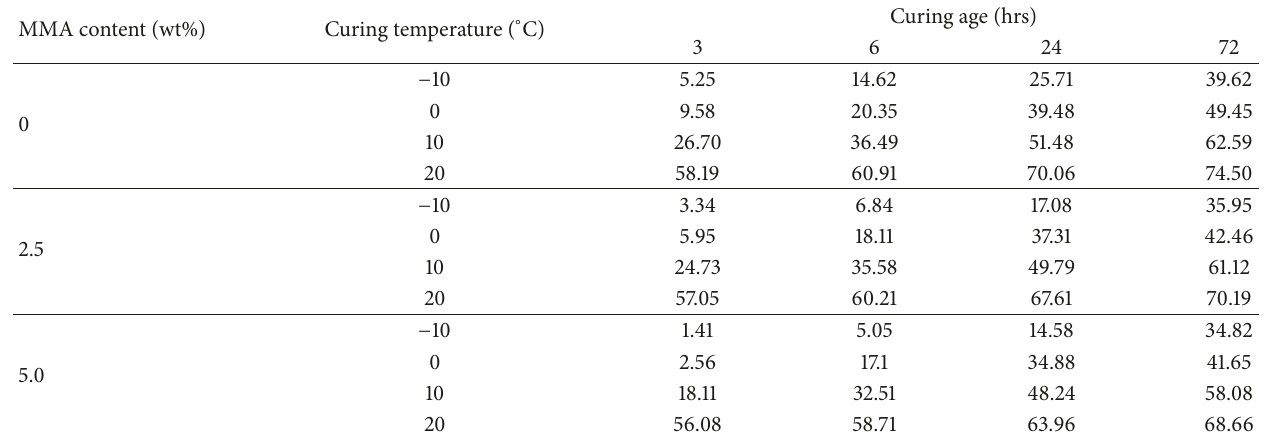
Table 9: Test results of compressive strength (by